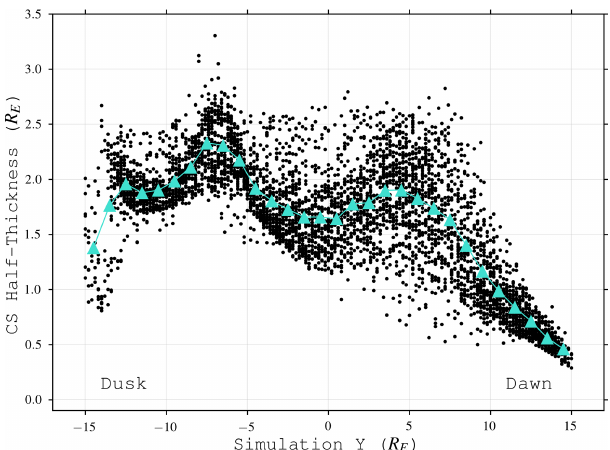
Figure 8. Best-fit current sheet half-thicknesses ( L CS ) derived by fitting Eq. (11) to 5037 cuts of B x along the z direction. These cuts were randomly sampled in the tail xy plane and over the simulation time period (see text). There is a bias towards the current sheet being thinner on the dawnside. However, the dawnside also sees a larger spread in thicknesses: this is a result of temporal effects (see main text for